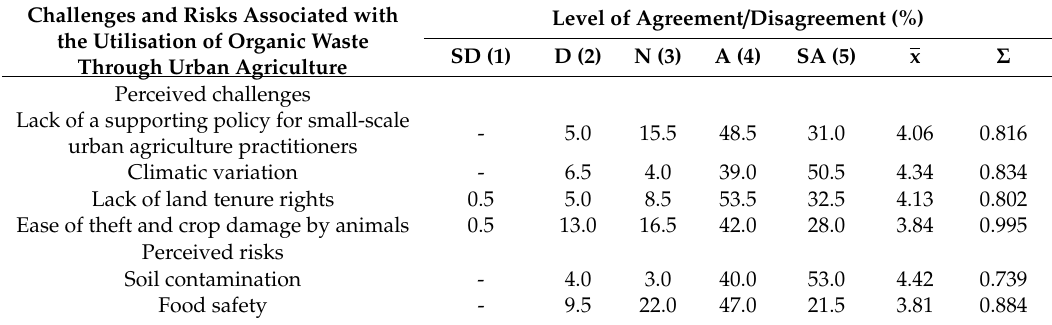
Table 5. The challenges and risks associated with the utilisation of organic waste through urban agriculture in the Durban South Basin as perceived by the respondents (n = 200).